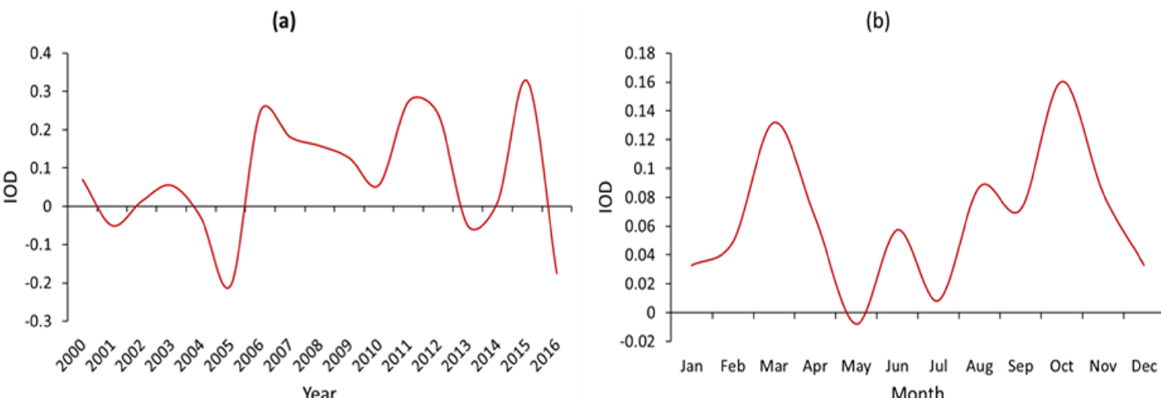
Figure 8. ( a )Yearly and ( b ) monthly changes in Indian Ocean Dipole (IOD) from 2000 to 2016 in the southern Indian Ocean.